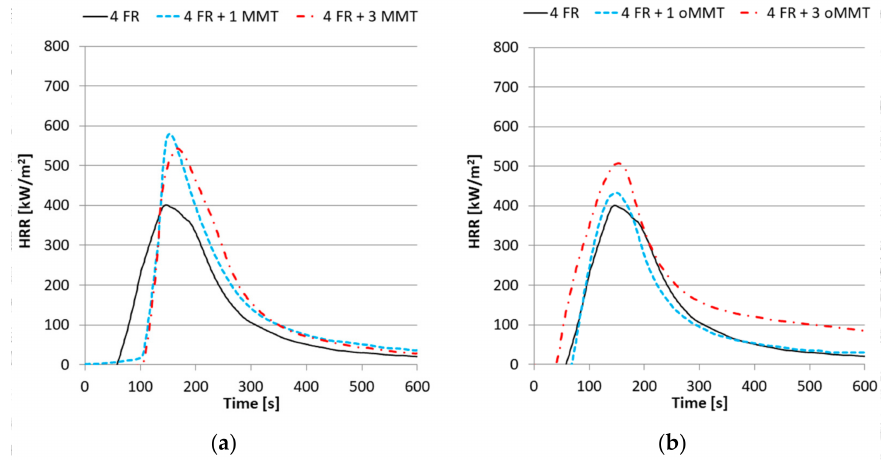
Figure 8. Heat Release Rate curves of nanocomposites with 4% FR and ( a ) MMT filler; ( b ) oMMT